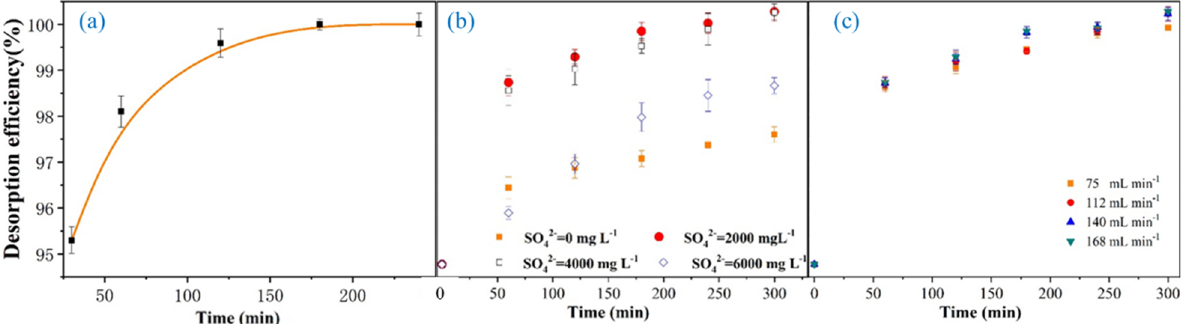
Figure 4. The desorption efficiency. ( a ) Study on the desorption efficiency of SO 42 − . ( b ) Effect of the ionic strength on the Cl − desorption efficiency. ( c ) Effect of circulation velocities on Cl − desorption efficiency.